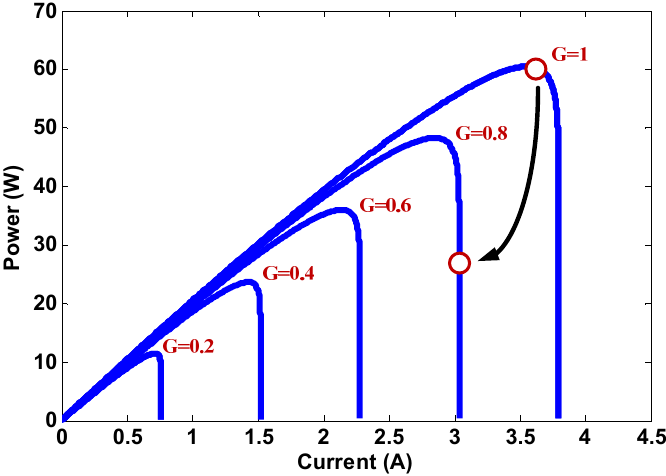
Figure 20. A diagram illustrating how the power versus current curve changes with